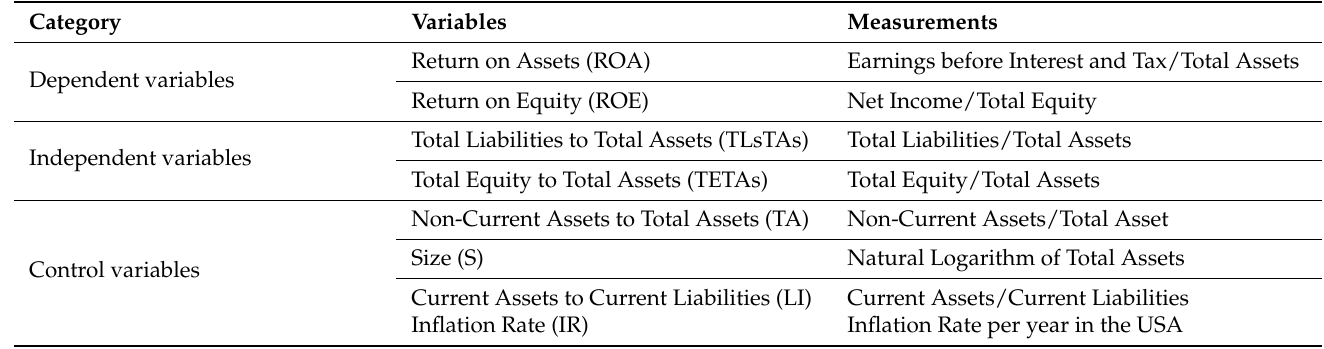
Table 3. Variables and